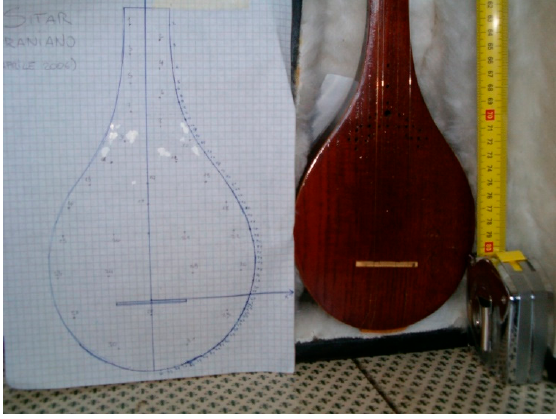
Figure 2. The Persian si-thar analyzed in this research in its original case.